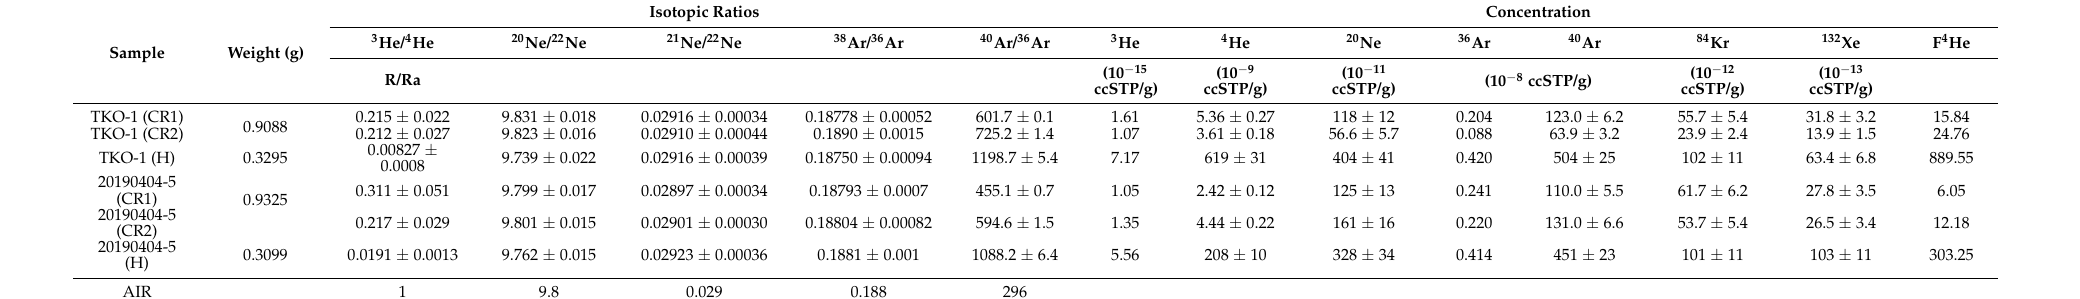
Table 3. Noble gas isotopic composition of quartz separate sample from the Thongkai-Ok deposit, the Vangtat orogenic Au belt.